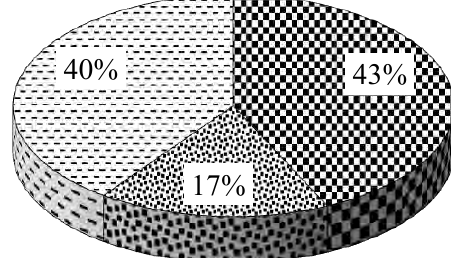
Fig.1. Percentage of correlation of time (days), spent by coaches for composing of competition compositions of individual